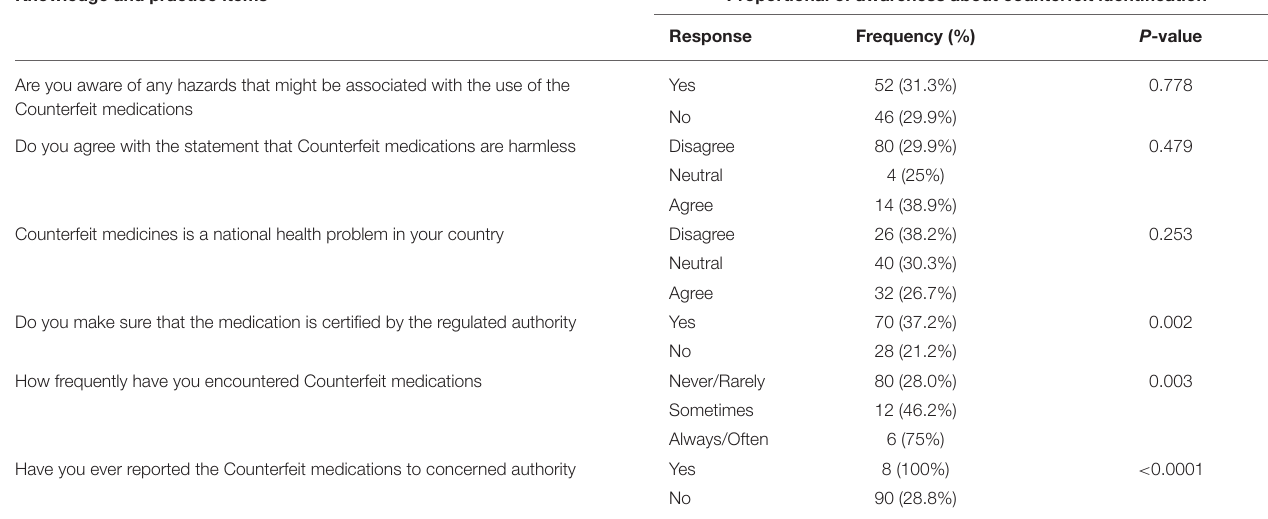
TABLE 5 | Counterfeit identification according to knowledge and practice factors. Knowledge and practice items